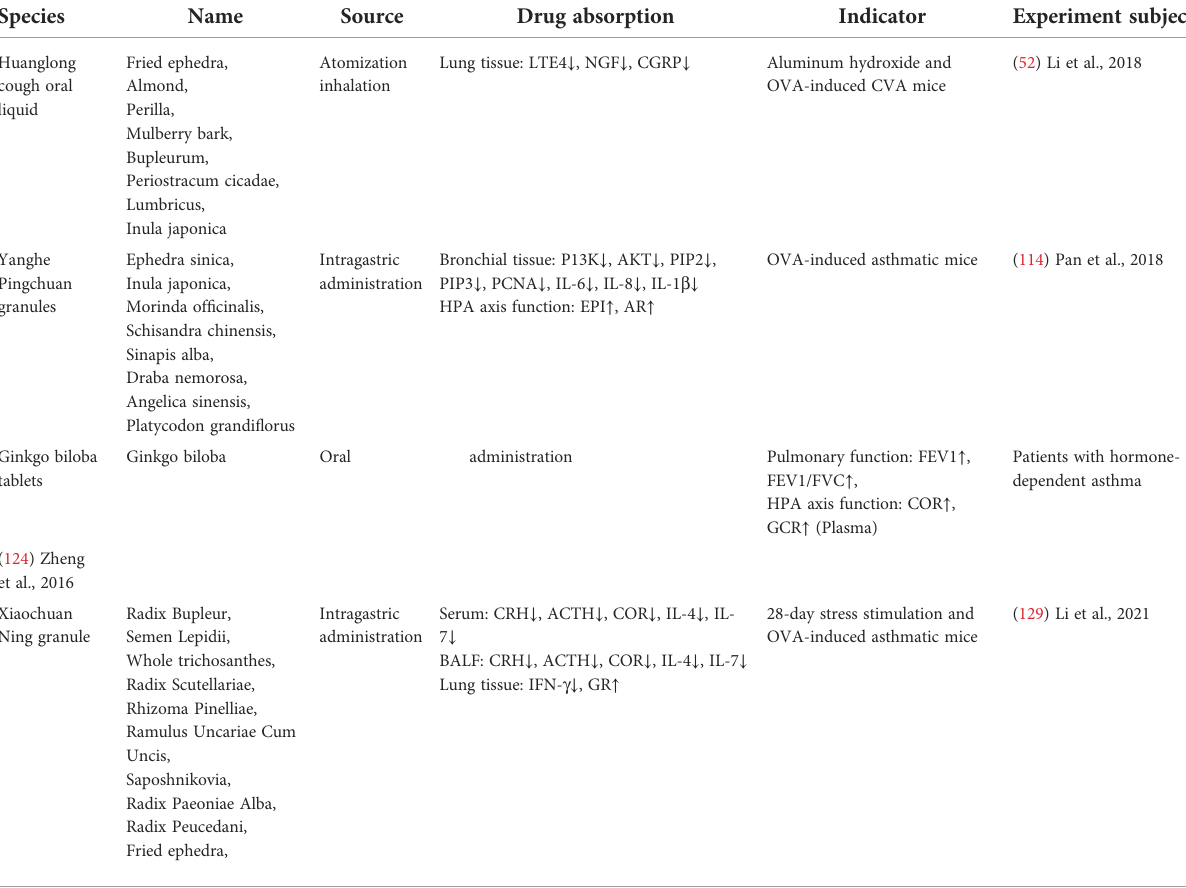
TABLE 4 The mechanism of traditional Chinese patent medicine in the treatment of asthma.